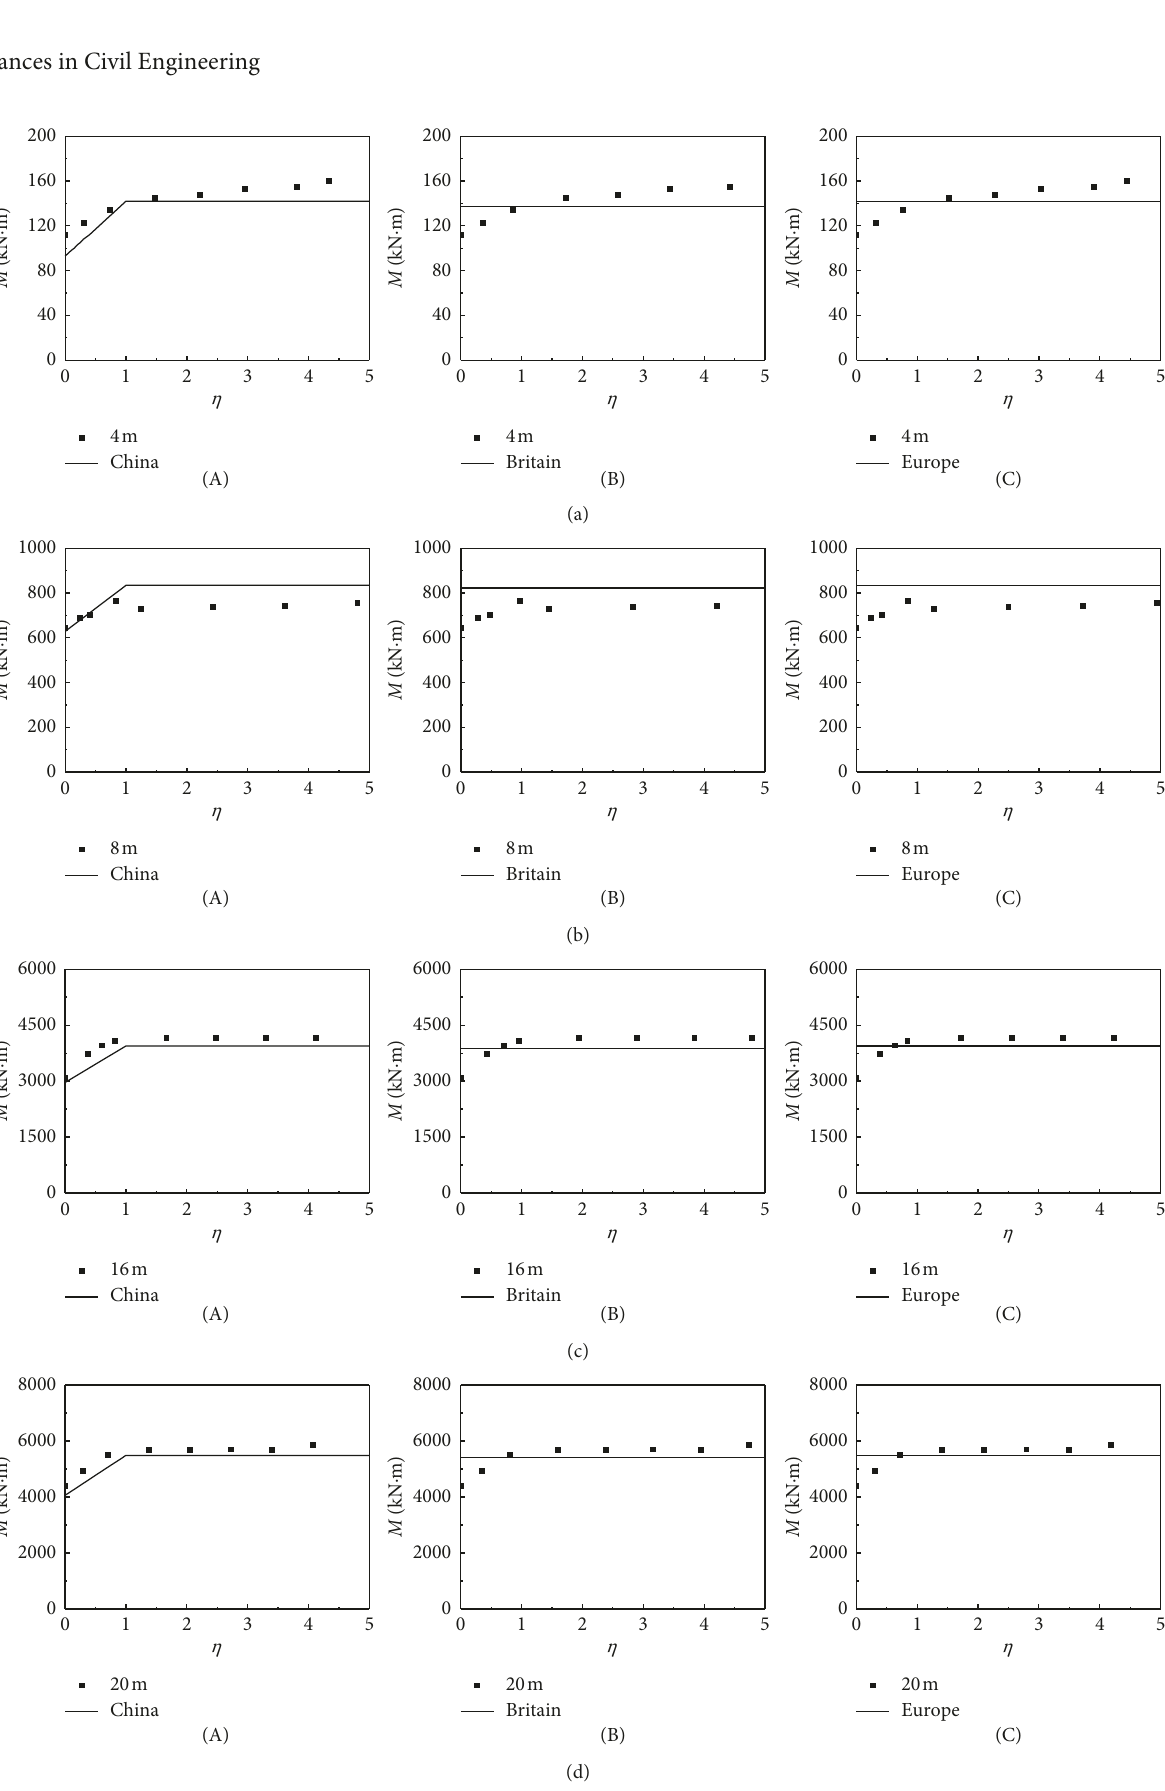
Figure 18: Influence of the beam length on M - ç relationship: comparison between the results of (A) GB 50017 and FEA, (B) BS 5950 and FEA, and (C) Eurocode 4 and FEA. (a) l � 4 m. (b) l � 8m. (c) l � 16m. (d) l �